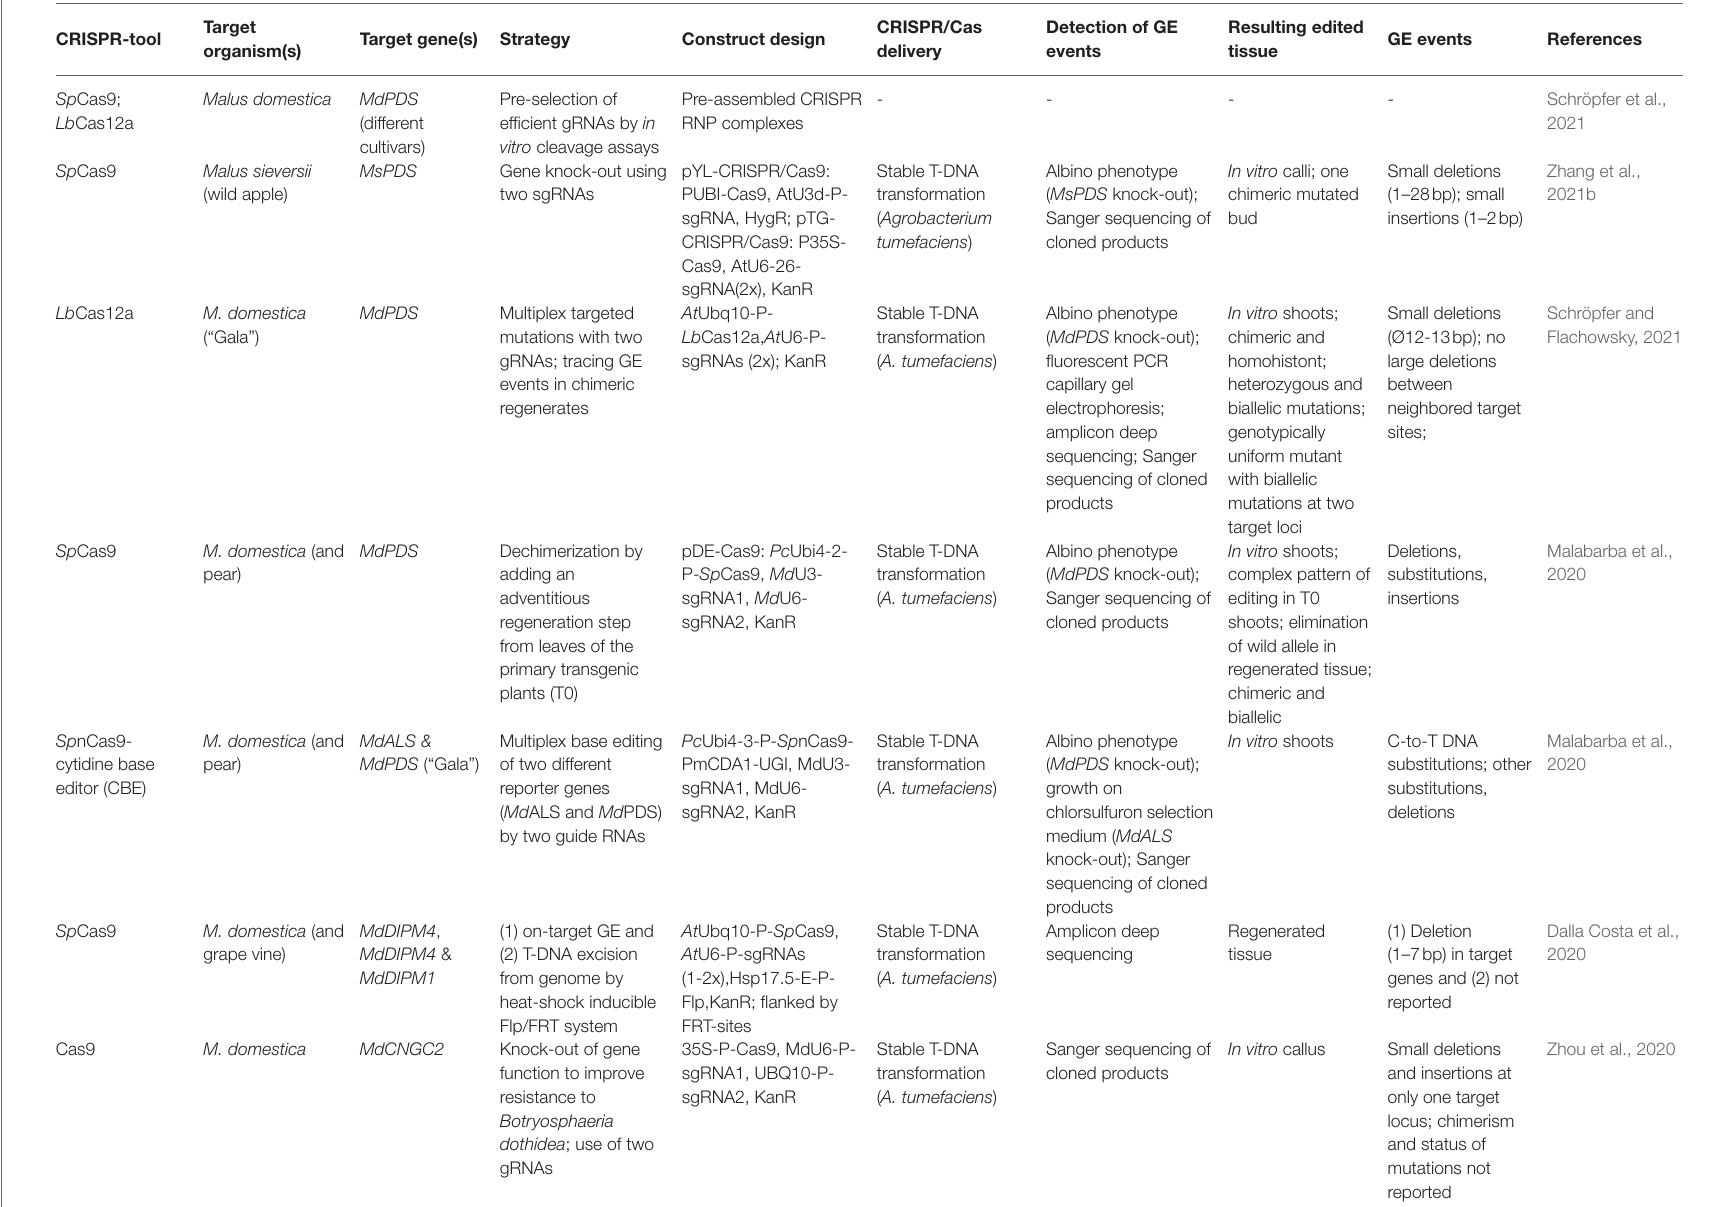
TABLE 1 | Overview of published reports on CRISPR/Cas-mediated GE of apple.